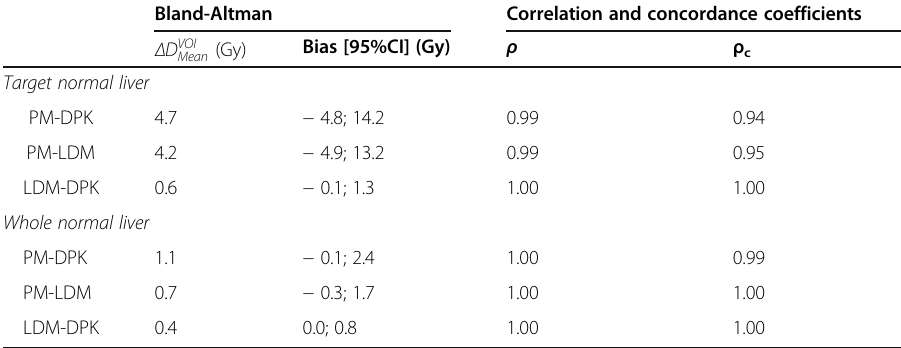
Table 2 Comparison among PM and both 3D dosimetry methods (LDM and DPK) in terms of mean absorbed dose delivered to target and whole normal liver: Bland Altman analysis, Pearson ’ s correlation, and Lin concordance